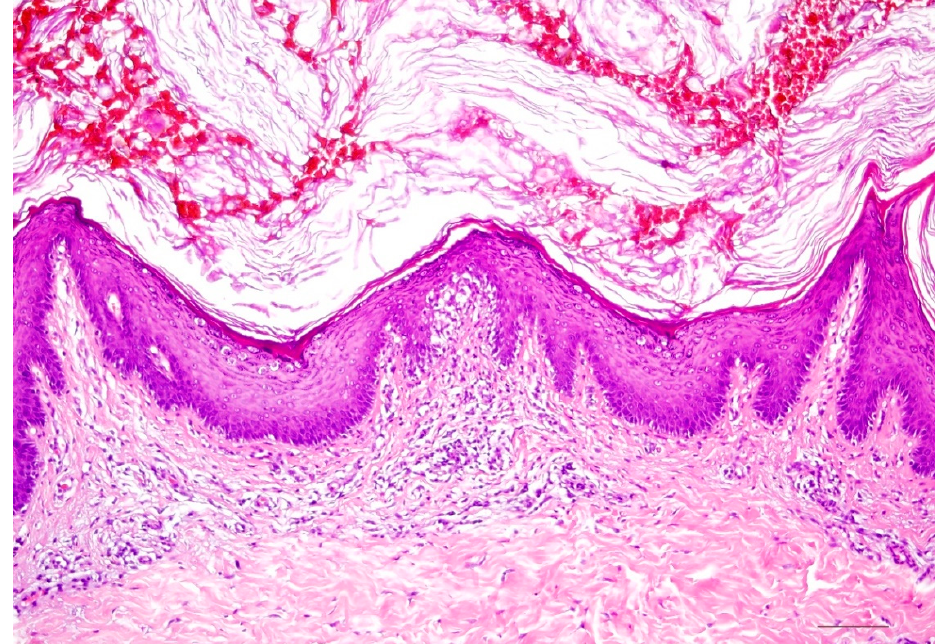
Figure 8. KID syndrome (keratitis–ichthyosis–deafness). Dyskeratotic keratinocytes with perinuclear halo (“bird’s eye”). HE stain, bar = 100 µm.